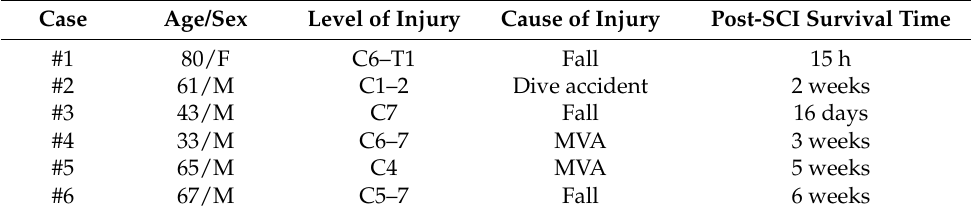
Table 2. Gender and age distribution of SCI cases included for immunofluorescent